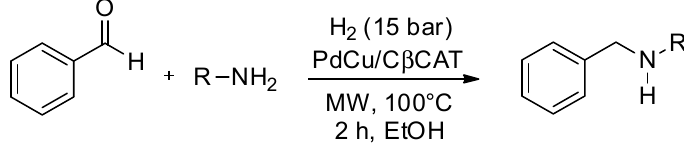
Scheme 2. C β CATs reductive amination reaction.